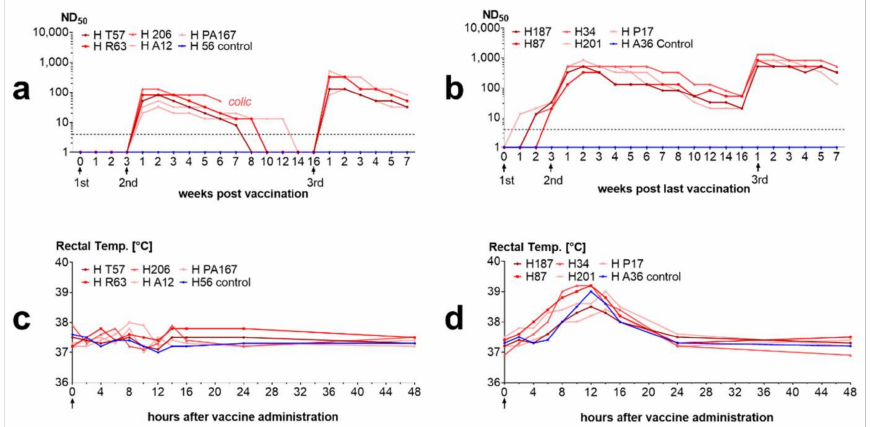
Figure 9. NT antibody kinetics in horses after vaccination with inactivated vaccines based on BoDV- 1 “Dessau”, following three applications of the nonadjuvanted vaccine ( a ), or ISA25-adjuvanted vaccine ( b ). Rectal temperatures after the first vaccine administration in horses vaccinated with the nonadjuvanted inactivated vaccine ( c ) and in the group vaccinated with the ISA25-adjuvanted inactivated vaccine ( d ). One horse developed colic and had to be taken out of the trial. Dashed lines, NT assay limit of